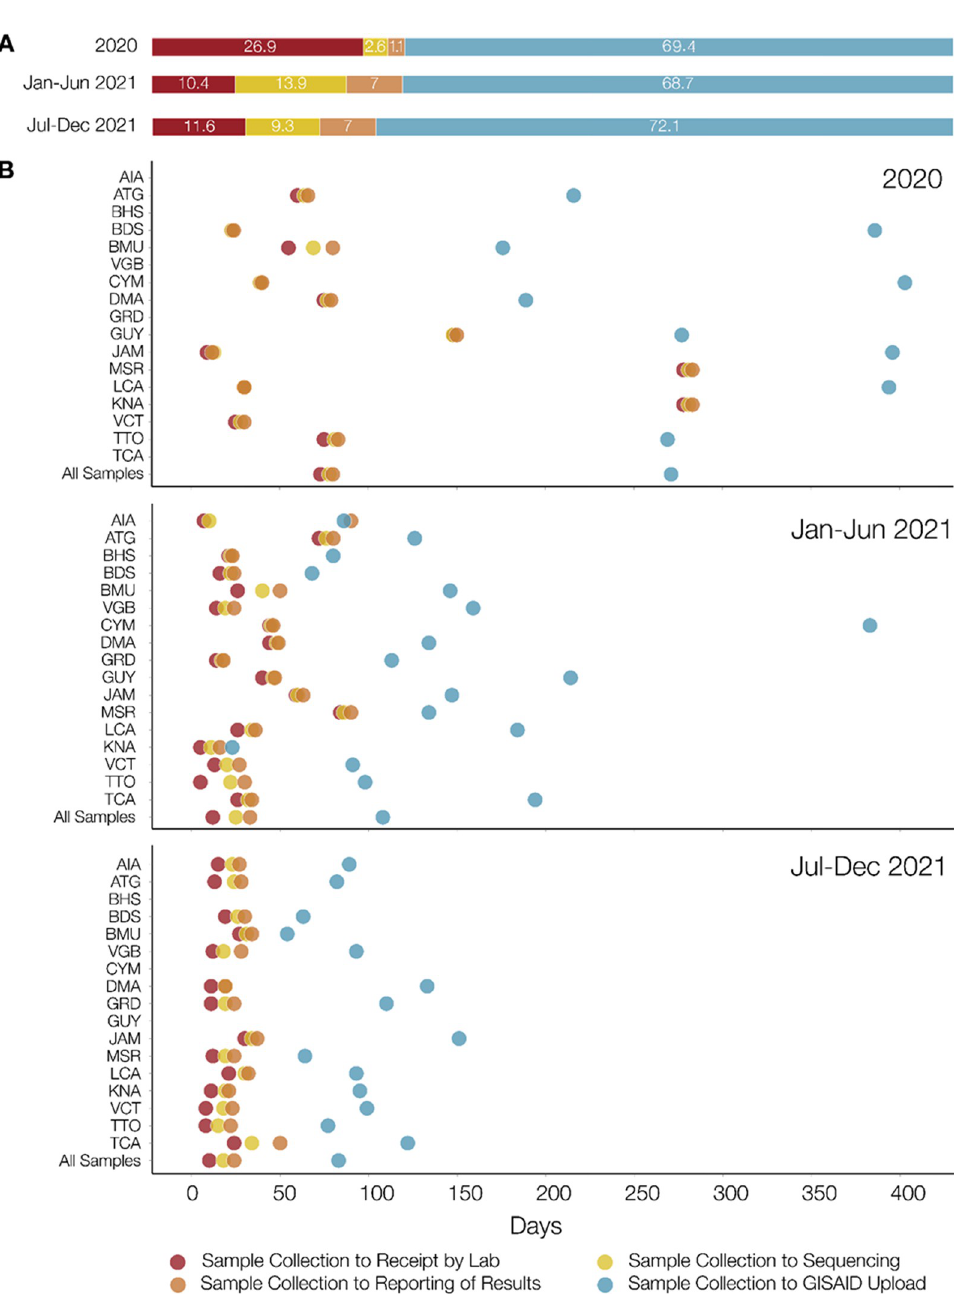
Fig 6. Turnaround times. (A) The average (across all 17 CMS) percentage time taken from (i) sample collection to receipt by the COVID-19 IMPACT laboratory (red), (ii) laboratory receipt to sequencing (yellow), (iii) sequencing to reporting of results to sending institution (i.e. Trinidad Public Health Laboratory (TPHL) or Caribbean Public Health Agency (CARPHA) (peach), and (iv) from reporting to sending institution to GISAID database upload (light blue) during three periods i.e. 2020, January 1st to June 30th 2021, and July 1st to December 31st 2021. (B) For each country, the average number of days from sample collection to: (i) receipt by the COVID-19 IMPACT laboratory (red circles); (ii) sequencing (yellow circles); (iii) reporting to sending institution (orange circles); and (iv) upload to the GISAID database (light blue circles). The times are shown for samples collected during three periods; 2020, January 1st to June 30th 2021 and July 1st to December 31st 2021. AIA = Anguilla. ATG = Antigua and Barbuda. BHS = Bahamas. BRB = Barbados. BMU = Bermuda. VGB = British Virgin Islands. CYM = Cayman Islands. DMA = Dominica. GRD = Grenada. GUY = Guyana. JAM = Jamaica. MSR = Montserrat. KNA = Saint Kitts and Nevis. LCA = Saint Lucia. VCT = Saint Vincent and the Grenadines. TTO = Trinidad and Tobago. TCA = Turks and Caicos Islands.